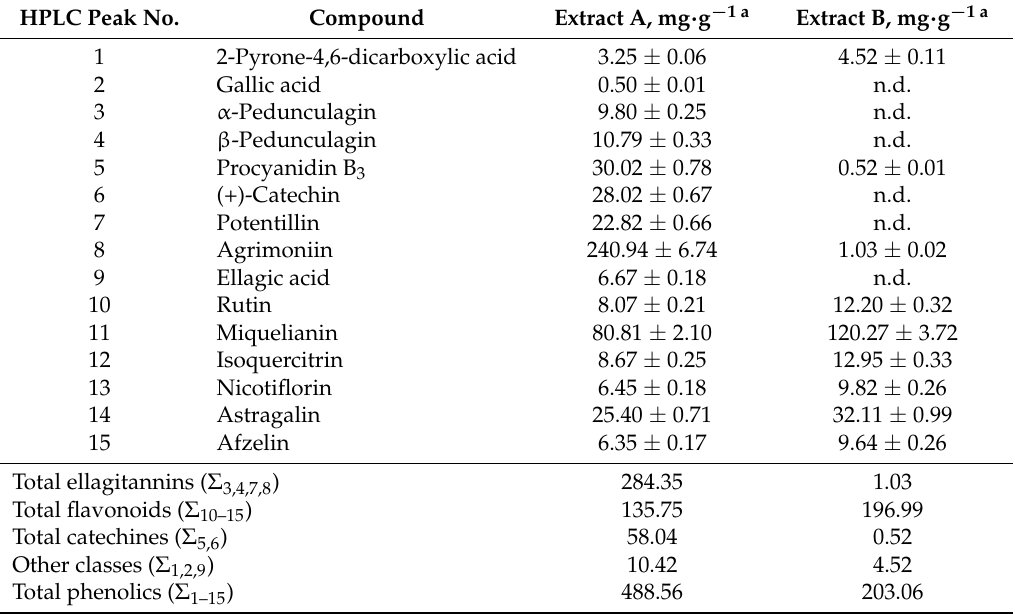
Table 3. Quantification of the components of C. palustre herb extracts before (extract A) and after ellagitannin removal (extract B).